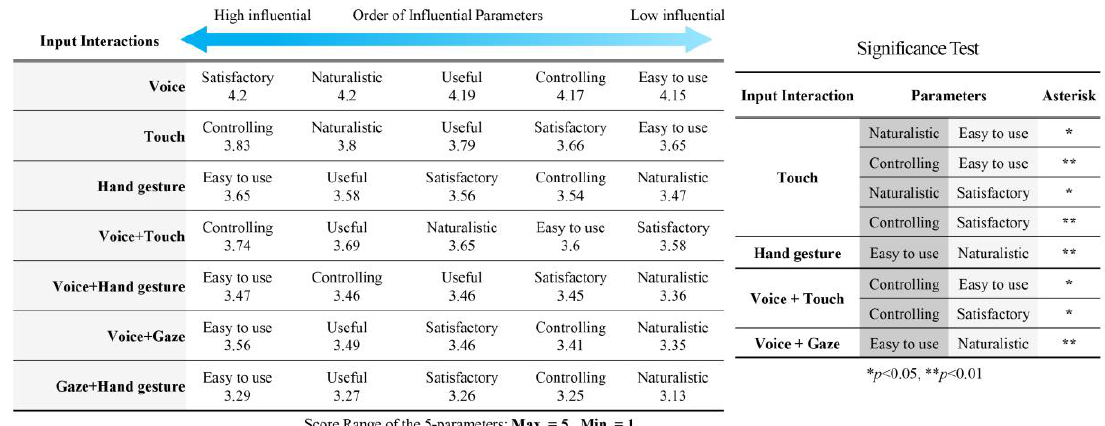
Figure 6. The influence order of five parameters in each input interaction ( left ) and the significance of the parameters in each input interaction ( right ). The deeper blue arrow indicates more influential